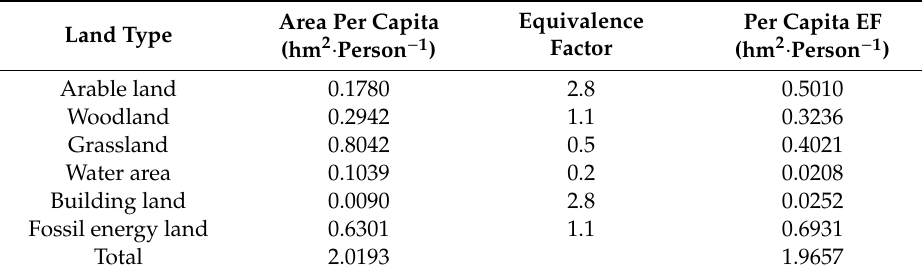
Table 4. The EF in northwestern Guangxi in 2015.